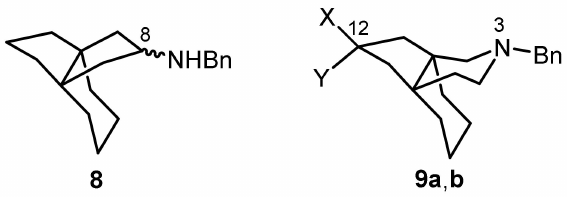
Figure 5. Propellan-8-amine 8 [48] and 3-azapropellanes 9 [43] served as lead compounds. At first, the ketones 10 – 12 were reductively aminated with benzylamine and NaBH(OAc) 344 to yield the benzylamines 8 , 13 and 14 . The pure diastereomeric alcohols anti - 11 and syn - 11 were converted separately into the benzylamines 11- anti - 13 and 11- syn - 13 , respectively, which were not further separated. Whereas the syn - and anti -configured benzylamines 8 were also not separated, the diastereomeric 1,3-dioxolanes 14 were separated by flash chromatography to obtain diastereomerically pure 8- anti - 14 and 8- syn - 14 . (Scheme 2).